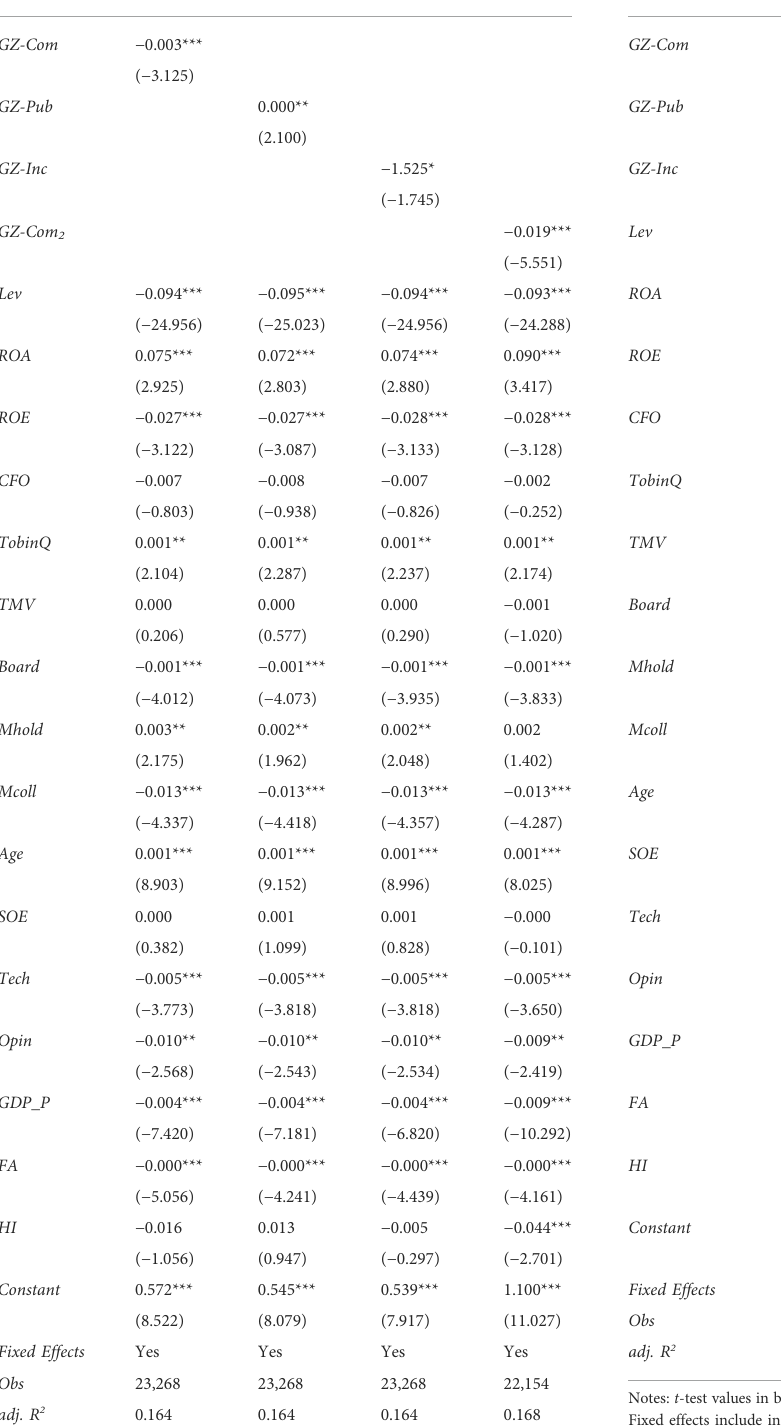
TABLE 5 Robustness test results after replacing the explained and explanatory